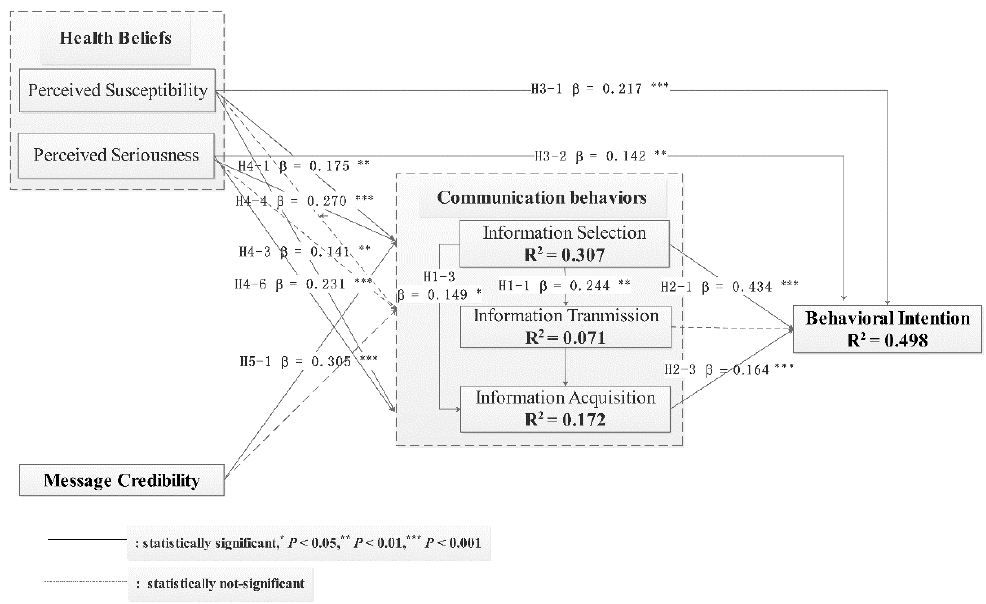
Figure 2. Research Model Test Results .